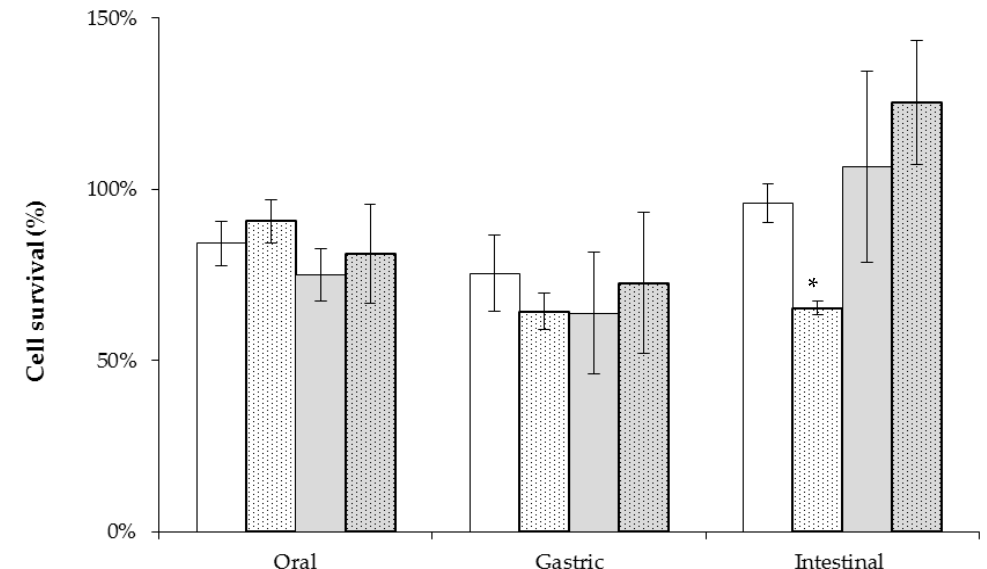
Figure 3. Analysis of protective influence of the O 2-substituted (1,3)- β - D -glucan against digestive tract stresses. Cell survival of L. plantarum WCFS1 when exposed to simulated oro-gastrointestinal conditions using as carrier matrix an oat (white bars) or rice (grey bars) product fermented by P. parvulus 2.6R (full bars) or 2.6NR (dotted bars). The percentage of survival was relative to that of unstressed control samples. * p < 0.01 compared with the other experimental conditions.